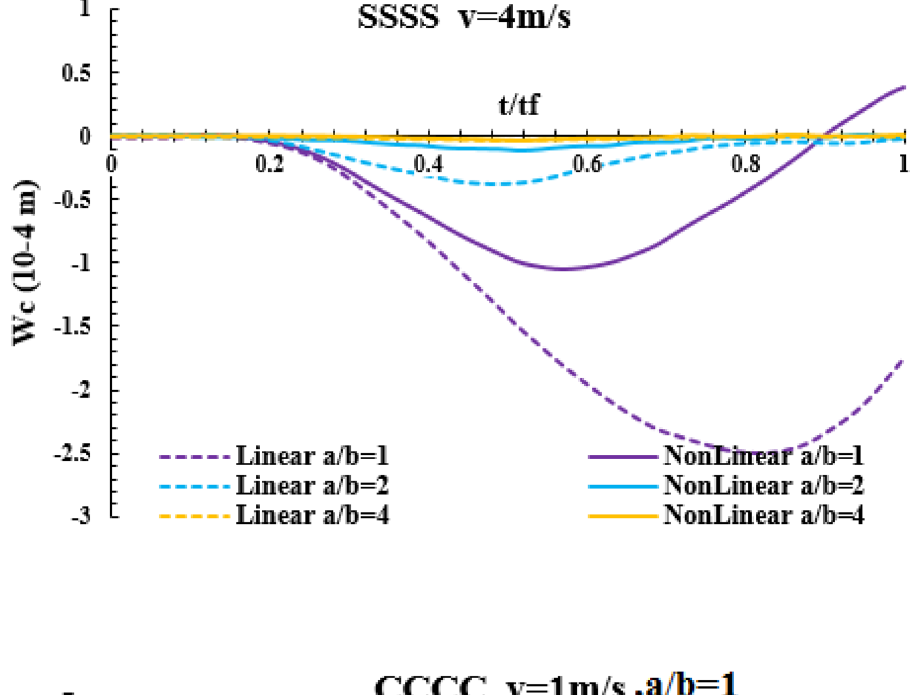
Fig. 17 The effect of aspect ratio on transient deflection of center-point of the plate (SSSS boundary condition)